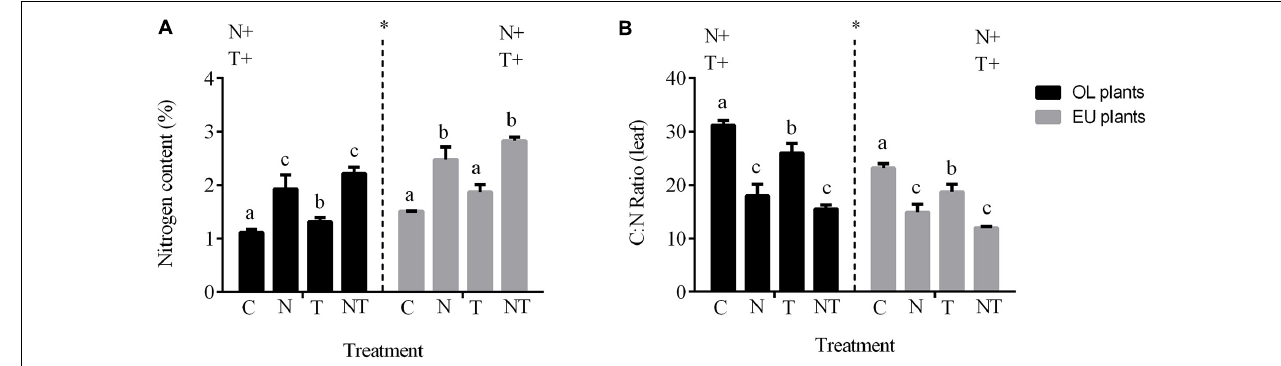
FIGURE 2 | (A) Nitrogen content measured in OL (oligotrophic) and EU (eutrophic) plants and (B) C:N ratio after 5 weeks of nutrient (N), temperature (T) and their combination (NT) exposure. Asterisks indicate differences between OL and EU plants (ANOVA 3-way); (+) indicates experimental factors significantly affecting the response variable (2-way ANOVA). Different lowercase letters indicate the groups of homogeneous means obtained in the post hoc ( P <